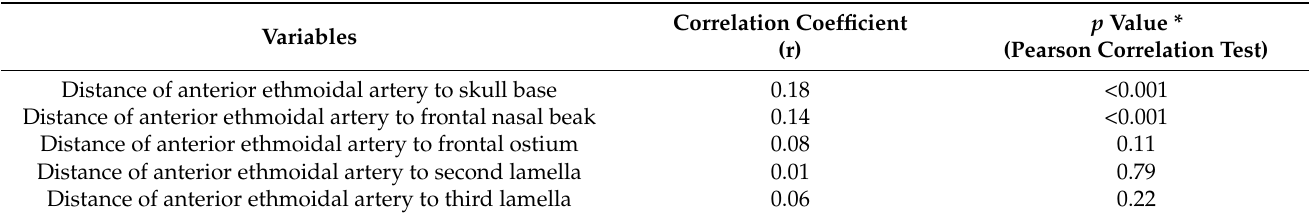
Table 4. The correlation between distance of anterior ethmoidal artery and the surrounding anatomy to the anterior ethmoid sinus